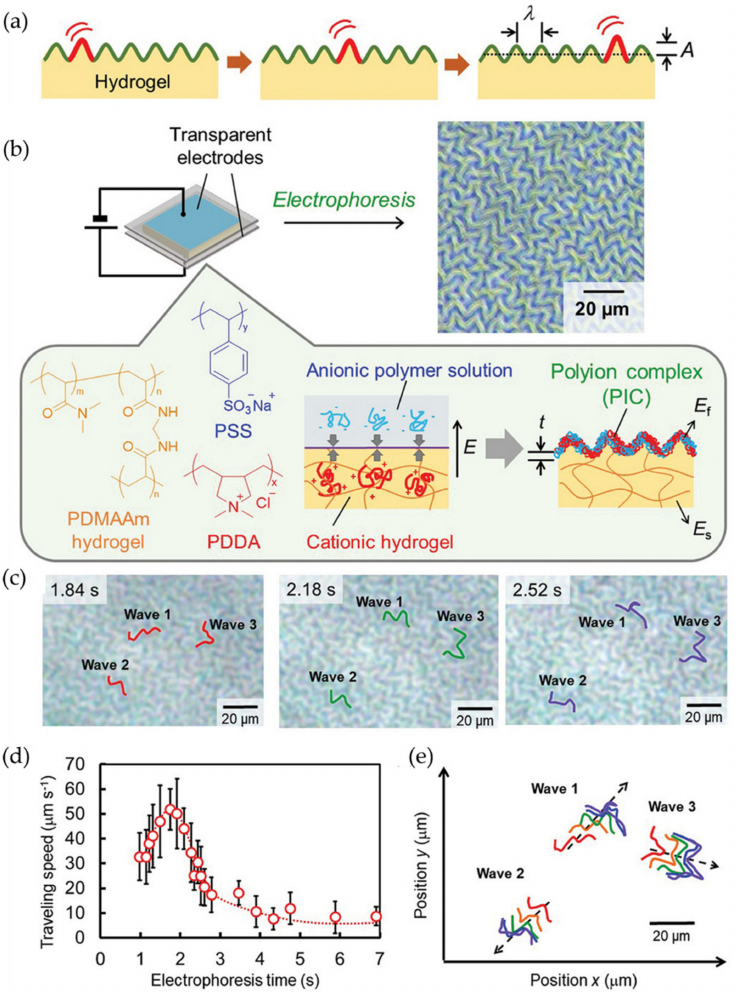
Figure 20. ( a ) Representative diagram of the generation of traveling waves of wrinkles on the hydrogel surface, ( b ) process of wrinkling of the hydrogel surface by electrophoresis, ( c ) images of the wrinkling process on the hydrogel surface during electrophoresis, ( d ) graph of the displacement velocity as a function of electrophoresis time and ( e ) Trajectories of three different waves tracked in the surface. Reproduced with permission from reference [77]. Copyright 2022, John Wiley & Sons,